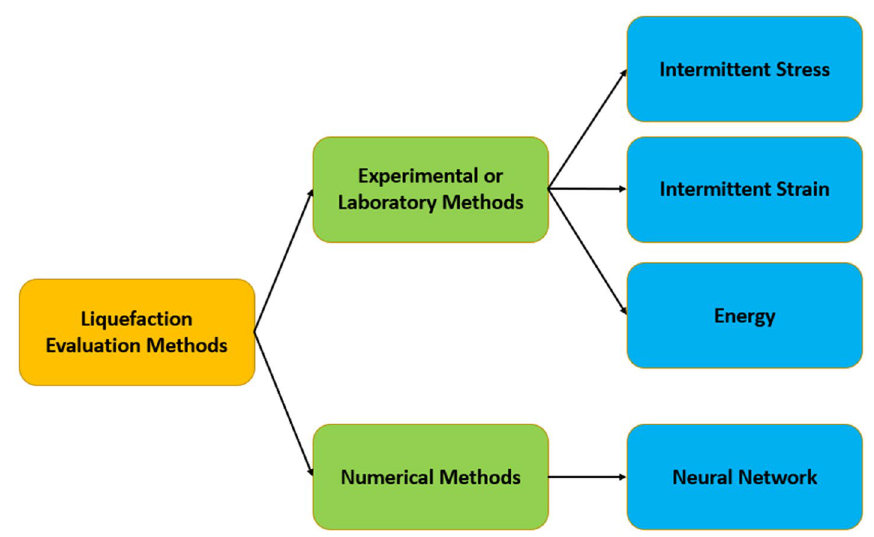
Fig. 8 The most common evaluation methods of lique-